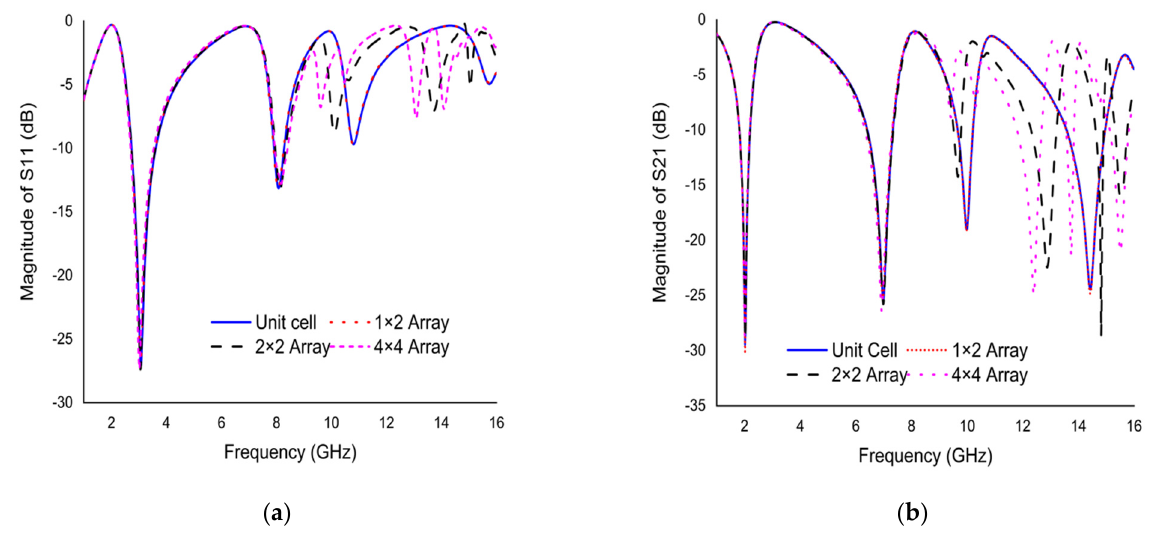
Figure 12. Scattering parameters plot using different types of array ( a ) S 11 ( b ) S 21 .